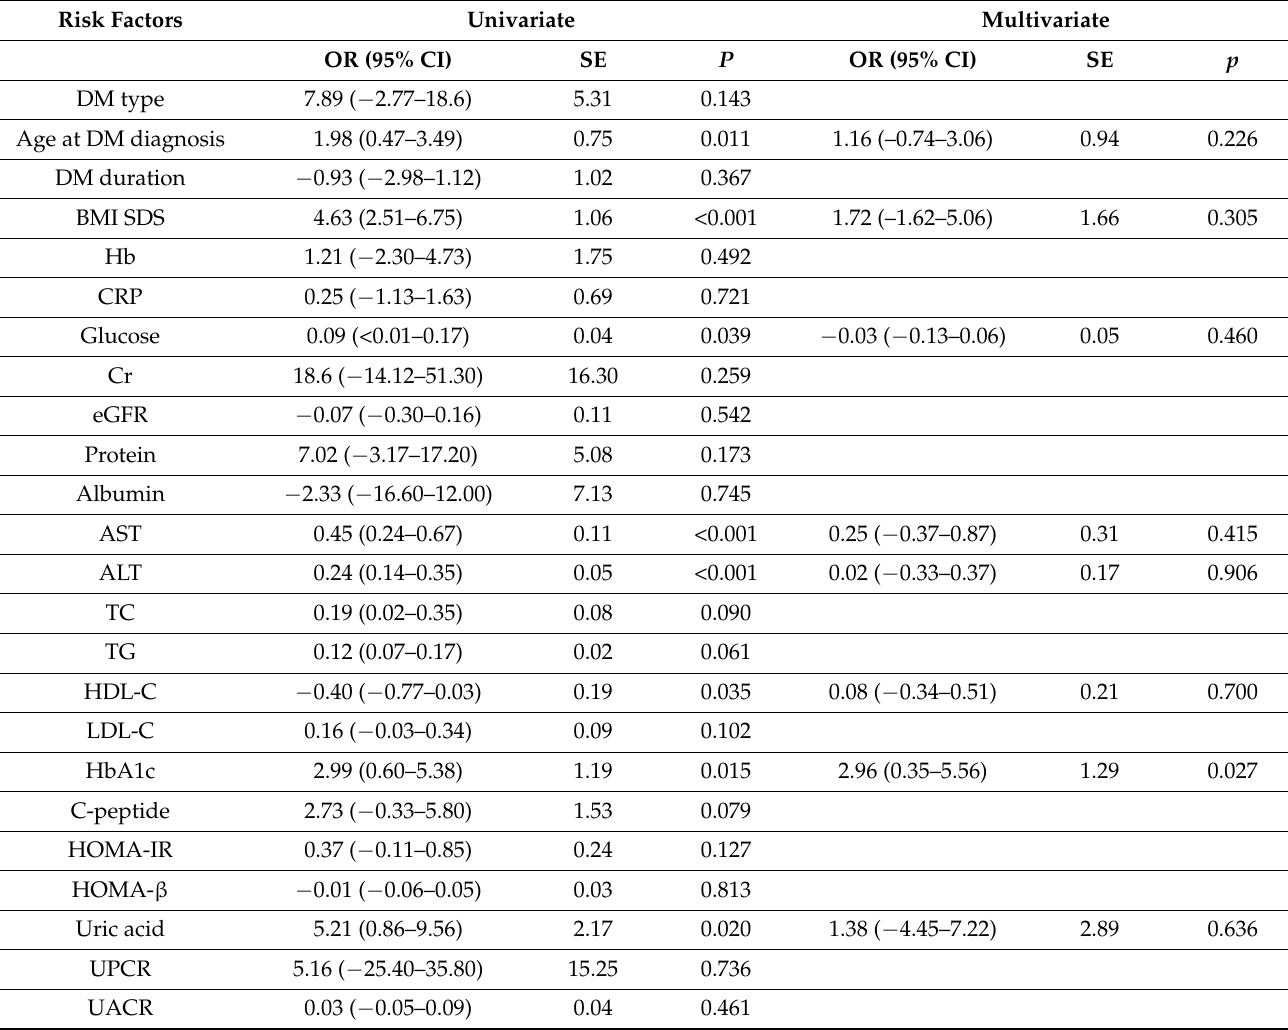
Table 4. Univariate and multivariate regression analyses of factors associated with increased plasma